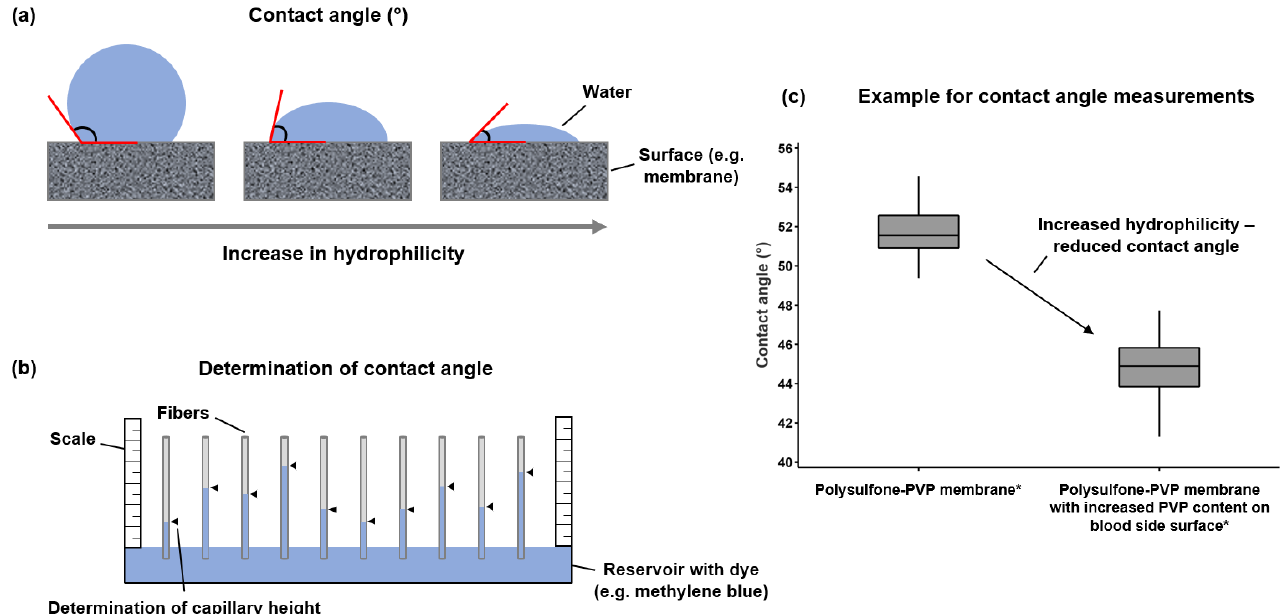
Figure 3. Determination of membrane hydrophilicity with contact angle measurements. Membranes with higher hydrophilicity have a lower contact angle than membranes with a lower hydrophilicity ( a ). To determine contact angle, fibers are placed in a water reservoir containing a dye (e.g., methylene blue) and the capillary height is measured with a scale after a defined time ( b ). Based on the capillary height and other parameters such as membrane geometry, the contact angle can be determined. When comparing two membranes with the same geometry but different hydrophilicity, the more hydrophilic membrane will have a higher capillary height and lower contact angle, as shown exemplarily for two membranes with the same geometry but different hydrophilicity ( n = 30 membranes, each; p < 0.001 ( t -test)) ( c ). * Shown are a polysulfone-PVP membrane (Helixone ® plus of the FX CorDiax 600 dialyzer, Fresenius Medical Care) and a polysulfone-PVP membrane with increased PVP content on the blood side surface (Helixone ® hydro of the FX CorAL 600 dialyzer, Fresenius Medical Care). 5. Maintaining Hydrophilic Modification of Dialysis Membranes While the increase in PVP content on the blood-side surface of the membrane leads to increased hydrophilicity and subsequently to lower protein fouling and better hemocompatibility as well as performance stability, the PVP must remain on the blood- side membrane surface in order to have an effect. Unfortunately, it has been well established that PVP can be eluted from the membrane during dialysis treatment [75,76]. This section discusses both the potentially undesirable effects of eluted PVP, as well as the predominant factors that lead to the phenomenon. 5.1. Undesirable Effects of Elutable PVP The reduction in PVP content caused by PVP elution comes not only with negative implications for the hemocompatibility profile and performance of the membrane, but PVP may itself have direct negative impacts on the patient. It has long been understood that PVP can be taken up by, e.g., macrophages and lead to storage disease by accumulation of PVP in different tissues or organs such as liver, kidneys or lymph nodes. This disorder has been seen in patients who received PVP injections as plasma substitute in former times [77,78], but up to now no data is available which shows that the elution of PVP from dialyzers may lead to a significant accumulation in the patients’ body. More recently some reports speculated that eluted PVP could be a cause for adverse reactions, such as hypersensitivity reactions or thrombocytopenia, which rarely occur during treatment with synthetic membranes [12,79–83]. Konishi et al. [84] investigated